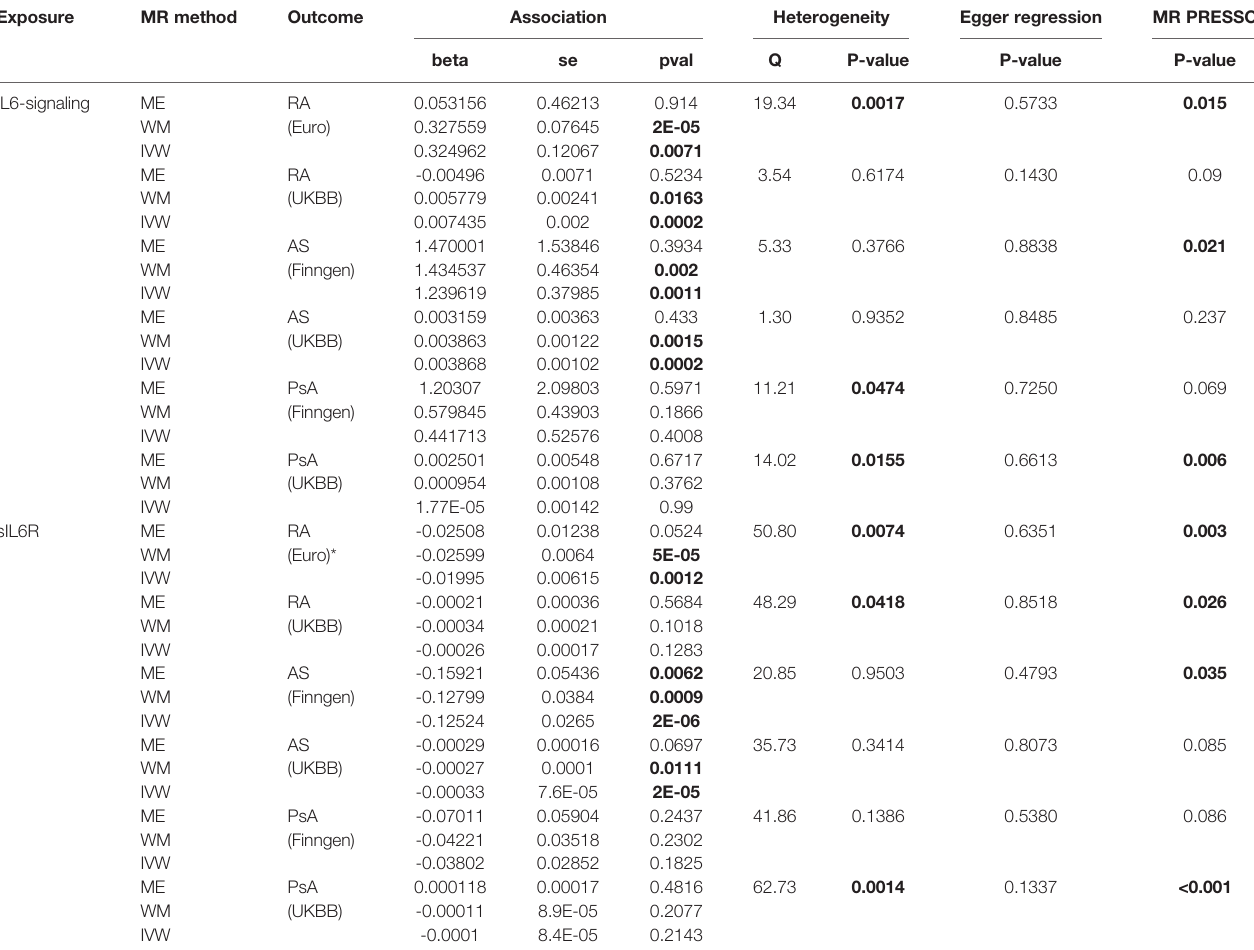
TABLE 1 | MR estimates of the causal effect of IL6-signaling and sIL6R level on the risk of autoimmune arthritis. Exposure MR method